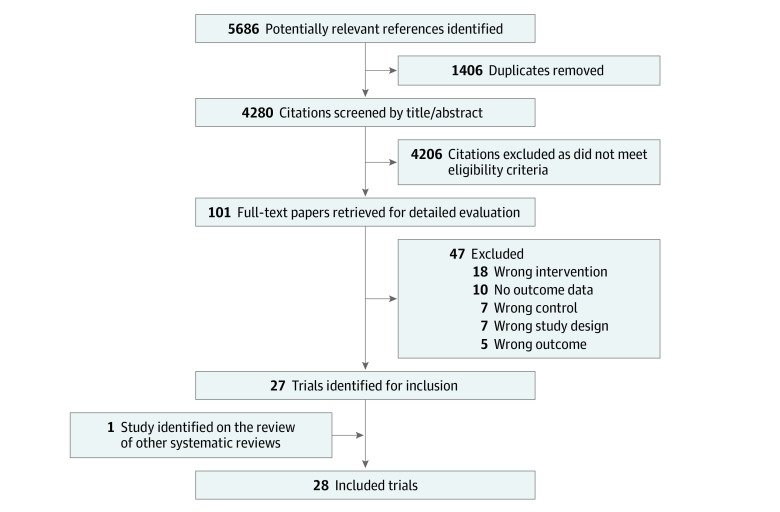
Flow Diagram of Trial Identification and Selection